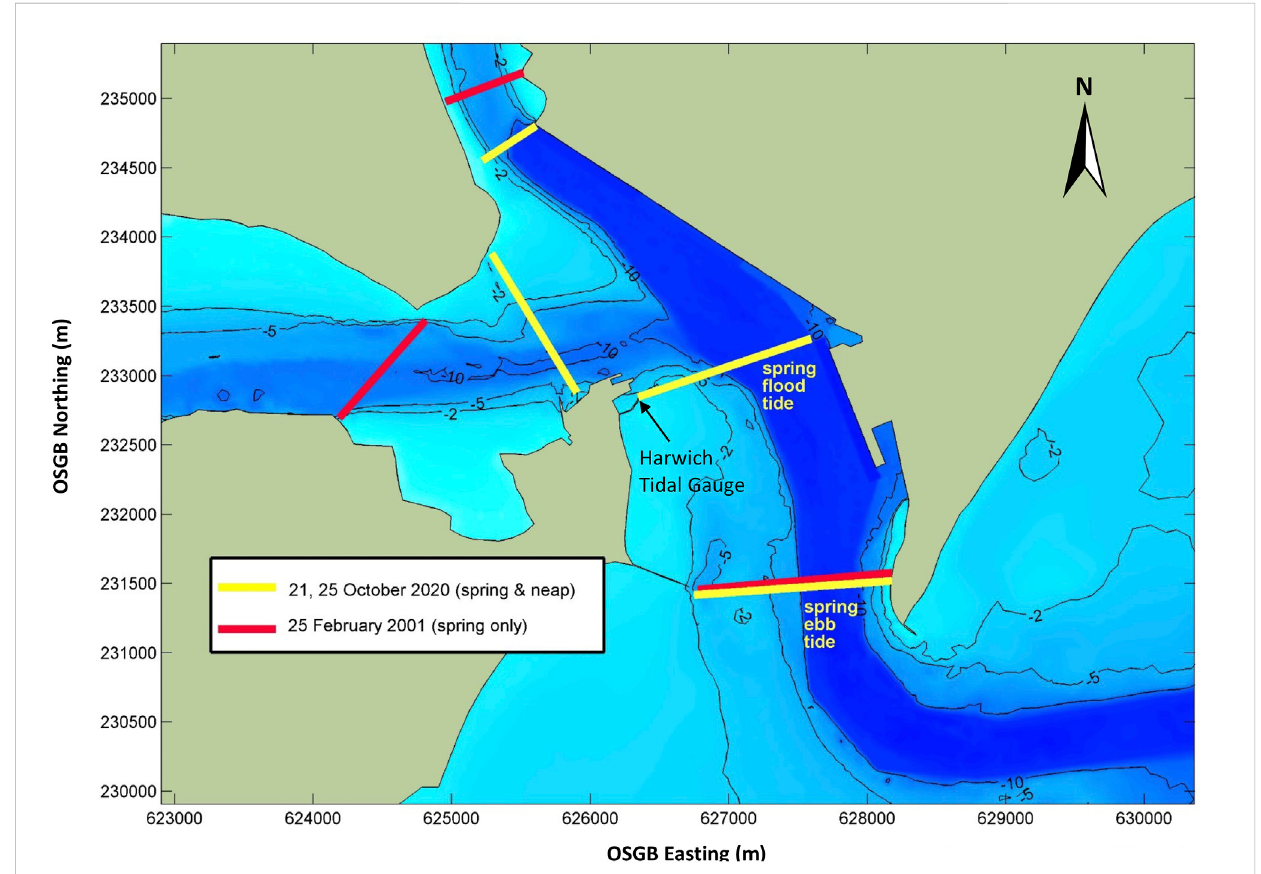
FIGURE 5 ADCP transect locations for 2001 and 2020 surveys. Coordinates are Ordnance survey of Great Britain